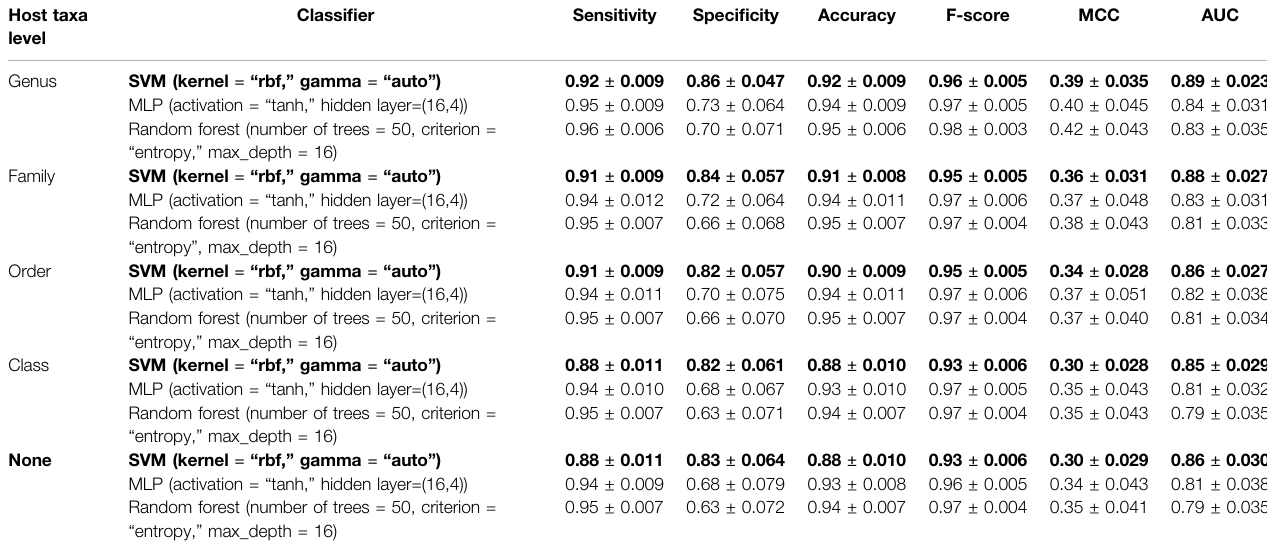
TABLE2| Performancemetricsofadenoviralinfectionpredictionmodels.RBF,RadialBasisFunction;AUC,AreaUndertheCurve;MCC,Matthew ’ sCorrelationCoef fi cient. Host taxa